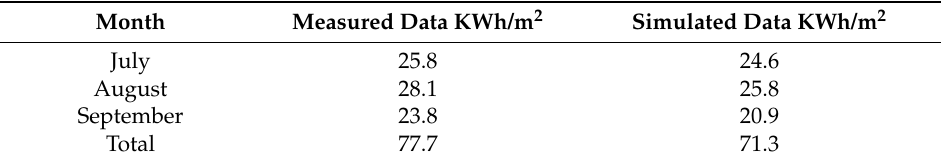
Table 2. Measured and simulated data.